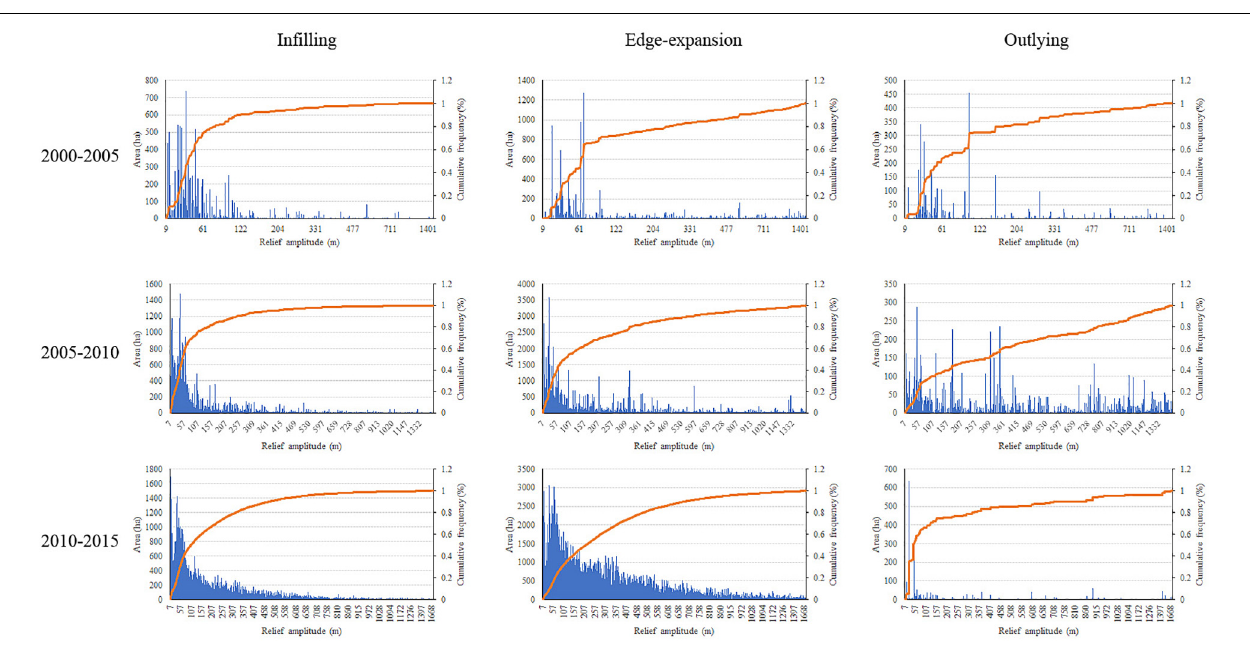
topographic relief amplitudes are 320 and 491 m, respectively, when the cumulative frequency is up to over 80%. For the outlying trajectory, at least 80% is distributed under the topographic relief amplitude of 781 m in 2005–2010, which is the highest distribution among those in the three-time